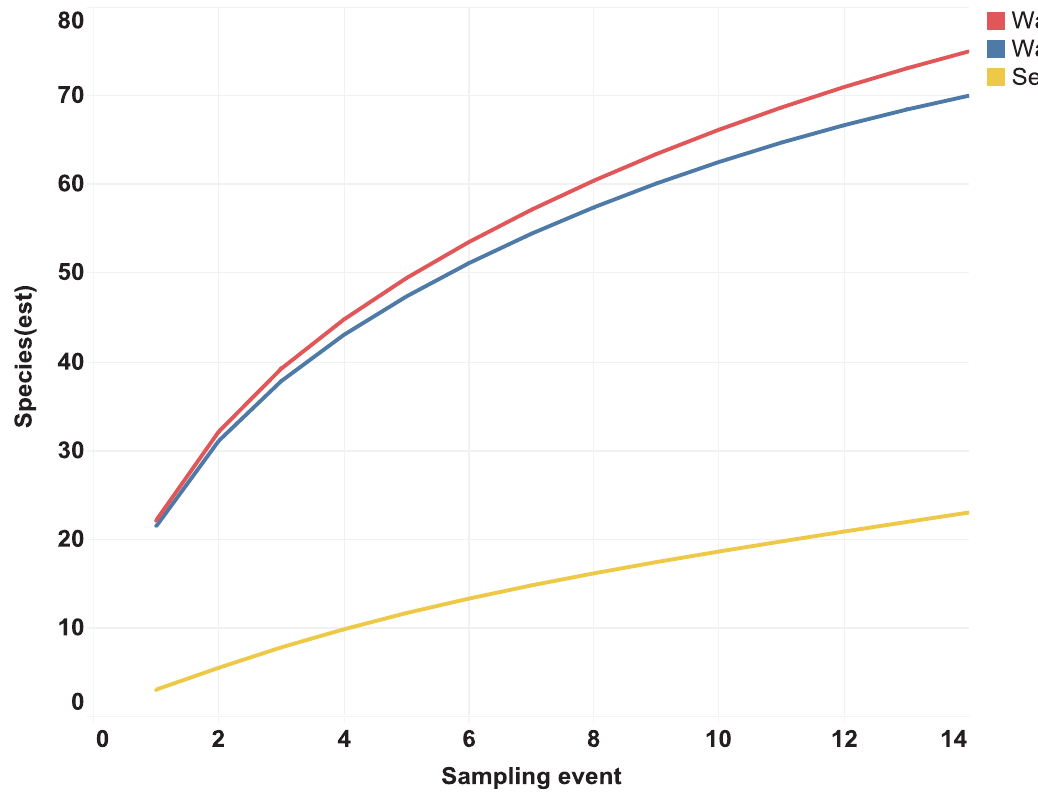
Fig 3. Number of species detected versus the number of samples analyzed for water, sediments, and combined. Species accumulation curves were calculated in EstimateS software with 1000 randomizations and classic formula for Chao 1 and Chao 2.